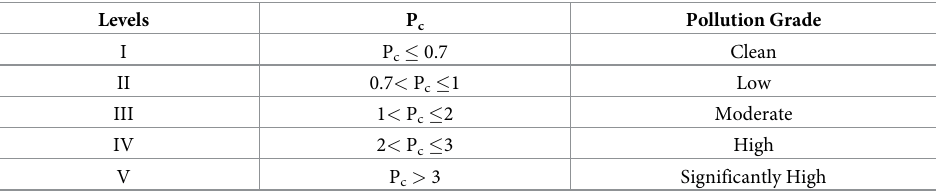
Table 2. Pollution grades of